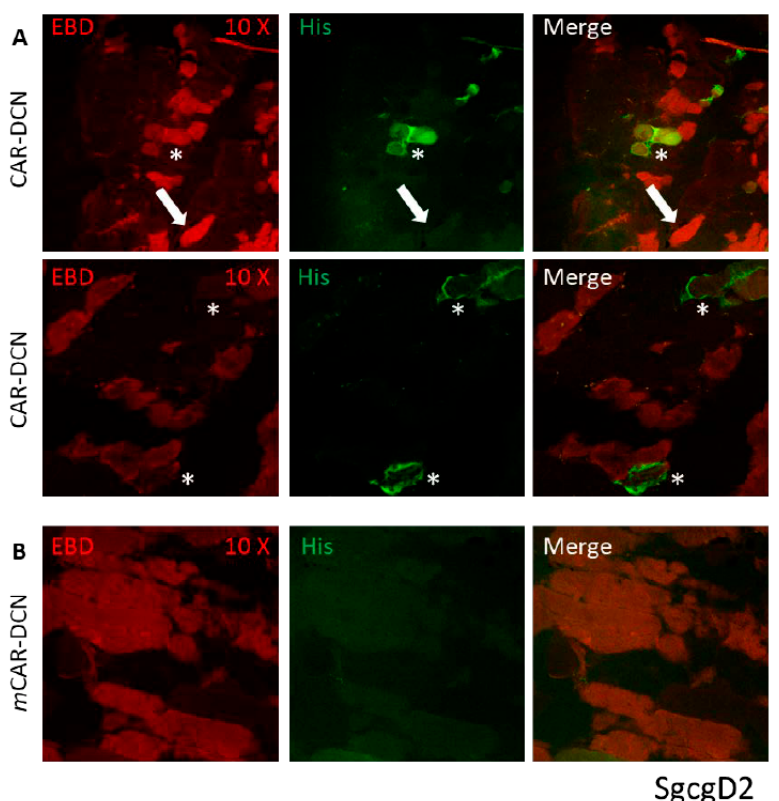
Figure 4. CAR-DCN localized to damaged muscle cells in the ɣ -sarcoglycan null quadriceps muscles, a second model of muscular dystrophy. ( A ) Similar to the mdx model injected CAR-DCN co-localized to a subset of damaged muscle tissues. The sgcgD2 mice received three weeks of IP injections every other day. Slides were visualized with EBD for membrane permeability (red, first column) and anti-histidine antibodies for the recombinant proteins (green, middle column), and last column shows merged images. In many EBD positive fibers, CAR has targeted to the sarcolemma (asterisks, top and middle rows). In other EBD positive fibers, no His-tag staining for the recombinant protein was detected (arrows). ( B ) The DCN protein containing mutant CAR (mCAR-DCN) never co-localized to damaged cells. Original magnification was 10×.